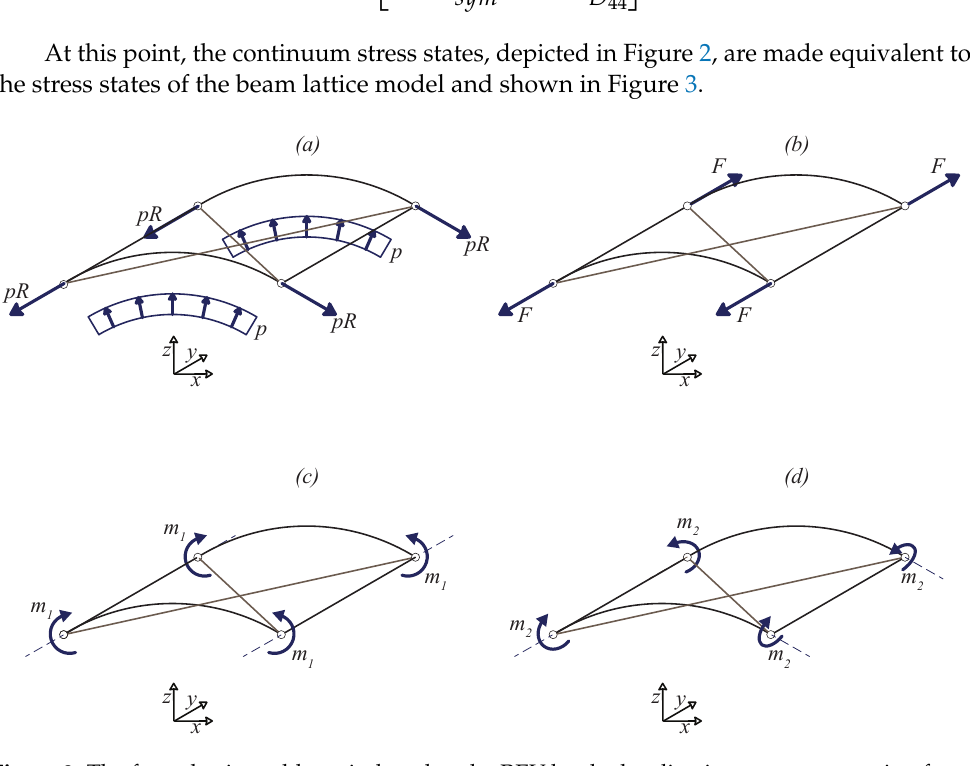
Figure 3. The four elastic problems induced to the REV by the localization operator, starting from the four uniform states of the continuum model. Refers to Equation (3) for definitions of boundary actions of ( a ), ( b ), ( c ) and ( d )